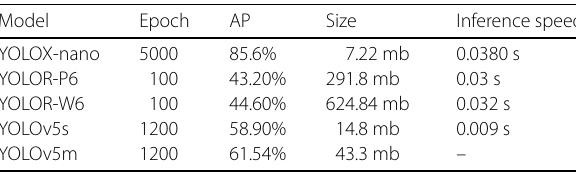
Table 3 Comparison of AP, Size, Inference Speed and epoch values of various Algorithm Model Epoch AP Size Inference speed